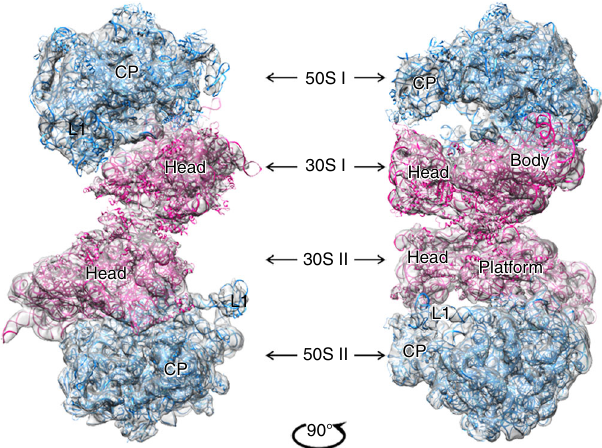
Fig. 1 Overall structure of the SA100S ribosome dimer. The paired ribosomes within the 6.8 Å cryo-EM map of the 100S are connected to each other through the 30S subunits (colored in pink ) and are oriented in a twofold symmetry relative to each other. The 50S subunits are colored in blue . Domain labels are: CP, central protuberance; L1, uL1 arm; Head, 30S subunit head; platform, 30S subunit platform; Body, 30S subunit